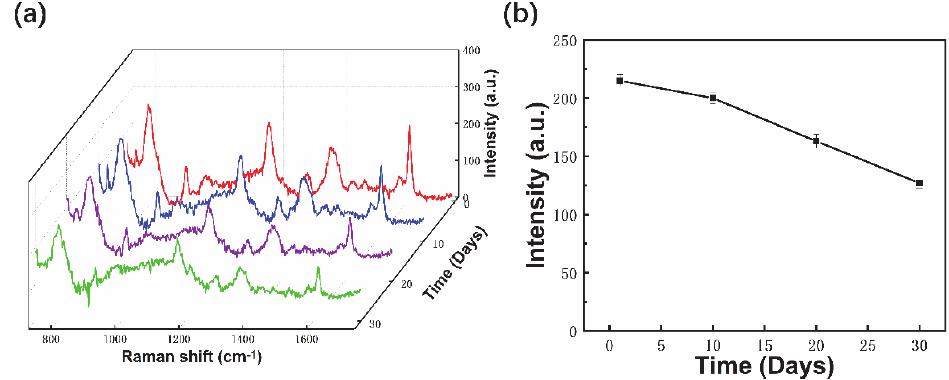
Figure 9. Raman spectra of 10 − 6 M CV molecules ( a ) and 1619 cm − 1 peak intensities ( b ) using fiber probe exposed in air for different durations.